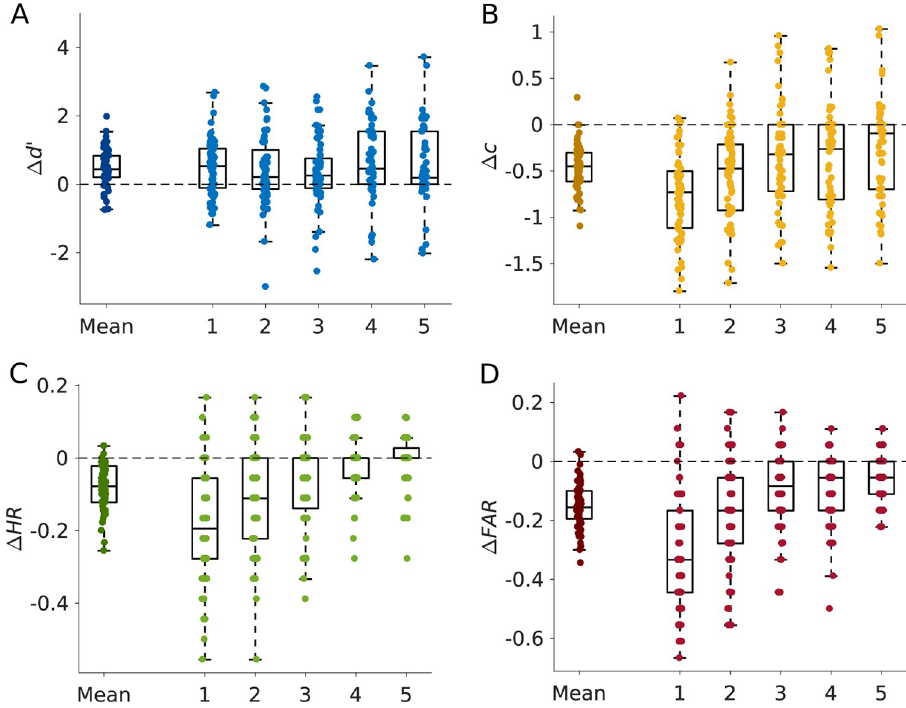
Fig 2. Behavioural results, expressed as difference between probe trials and preceding reinforced trials. Results are shown both for the mean across all five probe blocks (left) and separately for each probe block. Points reflect individual participants’ behaviour. (A) The sensitivity index d’ increased in probe compared to reinforced trials. (B) The negative bias criterion c decreased on probe blocks, indicating a reduced propensity to act on probe trials. (C), (D) Both hit rate ( HR , C) and false alarm rate ( FAR , D) decreased on probe blocks, but the decrease in FAR was more pronounced than the decrease in HR , which lead to the increase in d’ represented in (A).